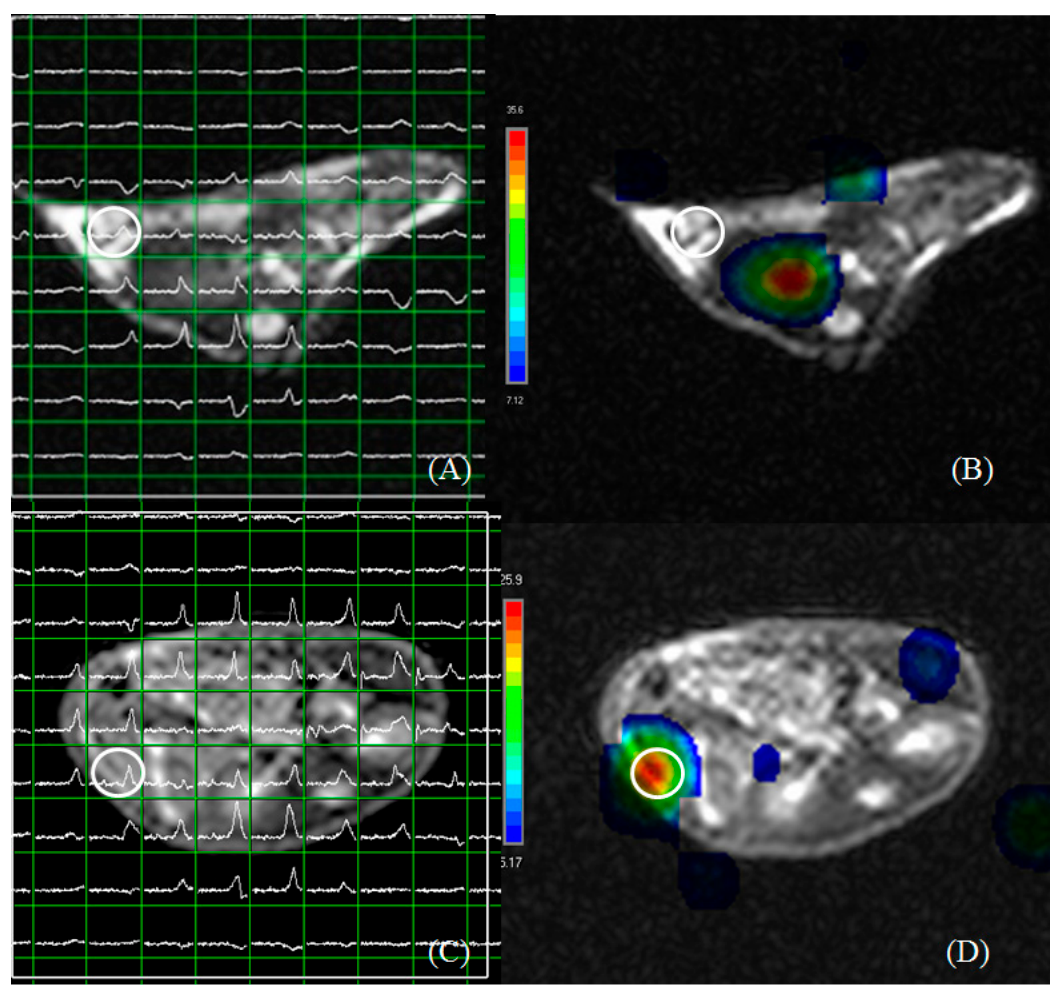
Figure 6. Multi voxel spectra of hepatoma in subcutaneous Hep-G2- ( A , B ) and Huh 7- ( C , D ) xenografted mice at 25 days post-inoculation. ( A ) The choline/creatine level at the inoculated point in ( B ). ( C ) The choline/creatine level at the inoculation point in ( D ). The maximum choline/creatine level was detected at some distance from the inoculation point in Hep-G2-xenografted mice. The maximum choline/creatine level was near the inoculation point in Huh 7-xenografted mice. Circles indicate the point of inoculation.